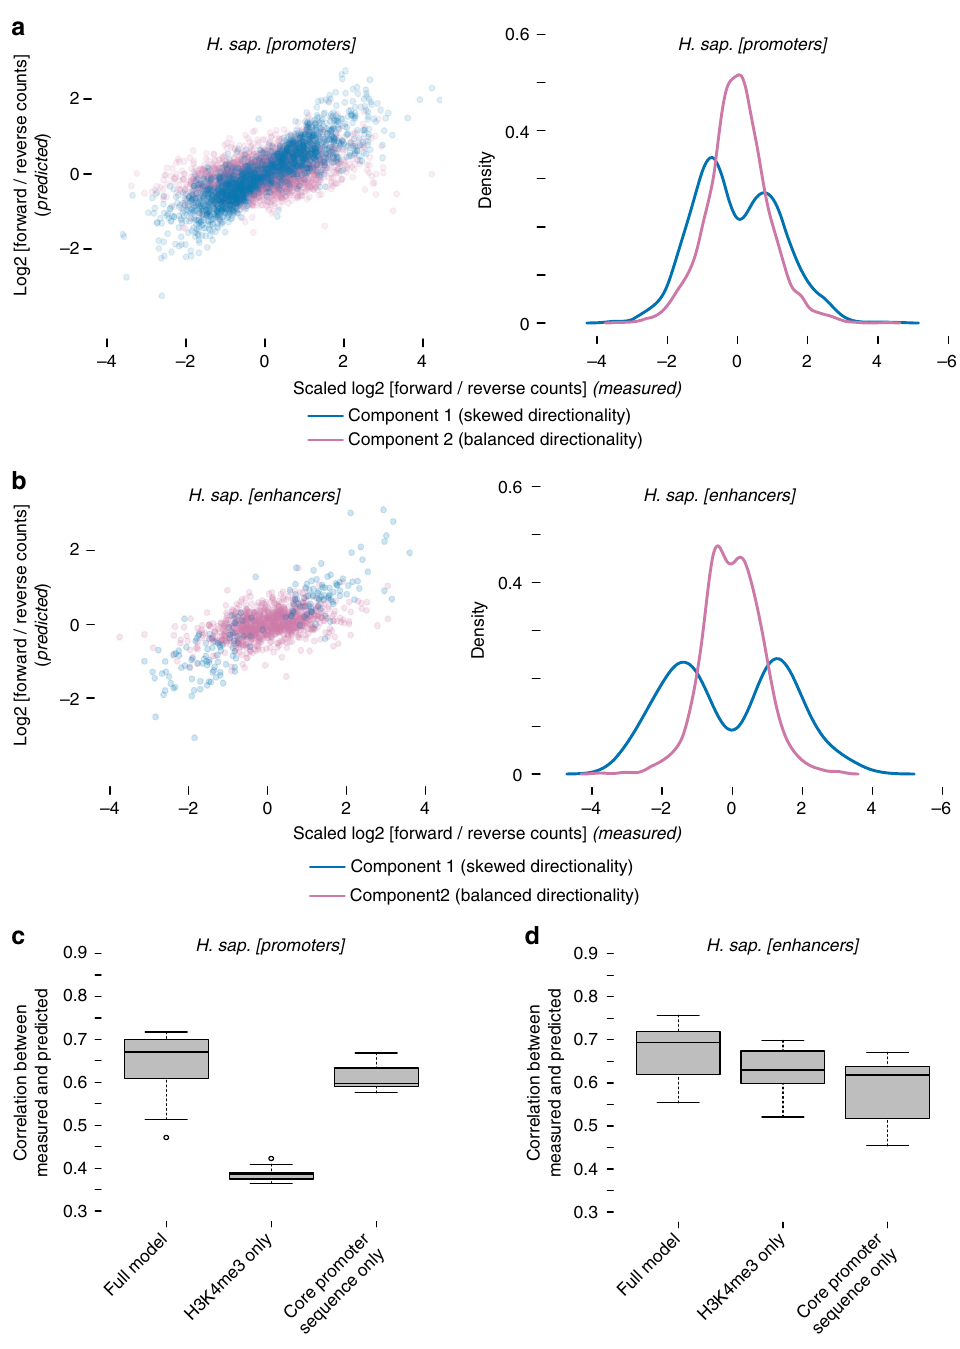
Fig. 6 H3K4me3 and core promoter sequence are predictive of initiation directionality. Predicted vs. measured transcription directionality in H. sapiens a promoter and b enhancer regions showing signi fi cant forward and reverse initiation levels ( n = 5231 and n = 1189, respectively) using a mixture linear model (left). Density plots of a promoter and b enhancer counts for different directionality groups predicted by the model (right). Models were trained on all promoter ( a ) and all enhancer ( b ) regions. Skewed (blue) and balanced (pink) directionality model components are displayed separately. c Tenfold cross-validation of three models including a model trained using core promoter sequence score ratios and H3K4me3 signal ratios, a model trained using core promoter sequence score ratios only and one trained using H3K4me3 ratios only. Boxplots show the correlation between predicted and measured transcription directionality for the test sets. Center line is the median, box represents the 25th and 75th percentiles and whiskers extend further by 1.58 times the interquartile distance divided by the square root of the number of data points. d Same as c but for initiation ratios show a correlation of 0.69 for promoters and measured forward/reverse initiation reveals the presence of two 0.65 for enhancers. Therefore, forward and reverse core promoter groups of promoters/enhancers: one with balanced initiation sequences and histone modi fi cations together are highly pre- directionality and one with skewed initiation directionality (Fig. 6a dictive of transcription initiation directionality levels (Fig. 6a, b). for promoters and Fig. 6b for enhancers). Further, the predicted Indeed, using the divergent promoter model to predict and experimentally measured forward/reverse transcription